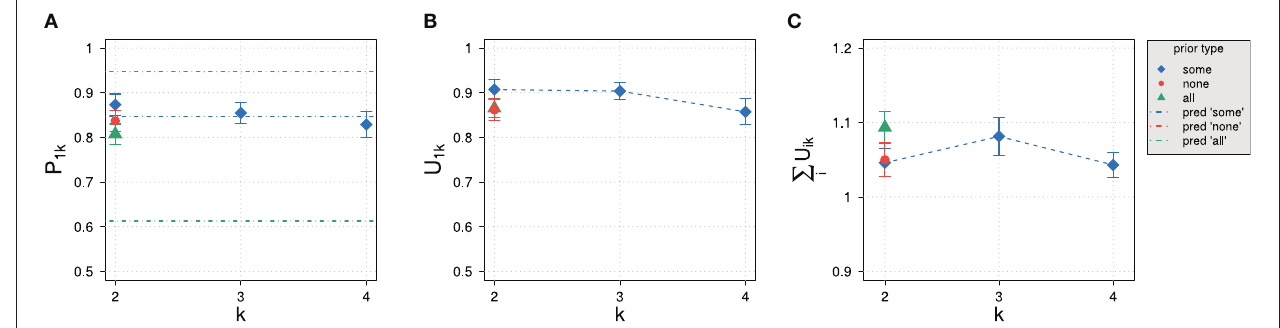
FIGURE 10 | Experimental results in Experiment 2 for different domain sizes k and prior types. (A) Posterior probability for normalized slider values P 1 k . Also indicated are approximate predictions for the exhaustivity for k = 2. (B) Unnormalized slider values U 1 k . (C) Average sums of unnormalized slider values.